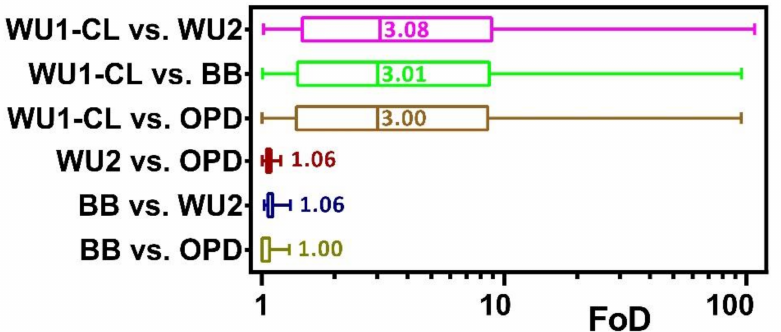
Figure 6. Box plots of the factor of difference, FoD, between the field-saturated hydraulic conductivity, K fs (mm · h − 1 ), data sets obtained by the BB, WU2, and OPD methods and the WU1 method with the cumulative linearization (CL) fitting method. The median values are also